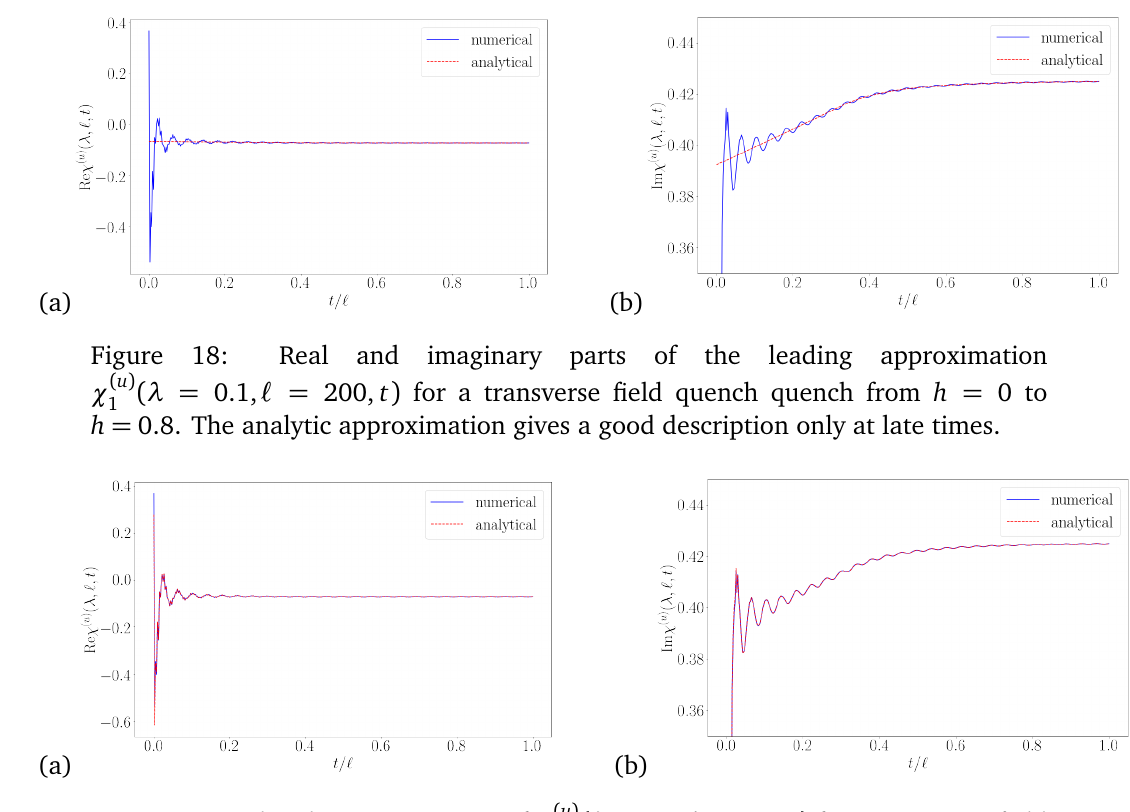
( u ) ( λ = 0.1, (cid:96) = 200, t ) for a transverse field Figure 19: Real and imaginary parts of χ 2 quench quench from h = 0 to h = 0.8. The analytical expression (red dashed line) is seen to be in excellent agreement with the numerical results, which have negligible errors on the scale of the figure.